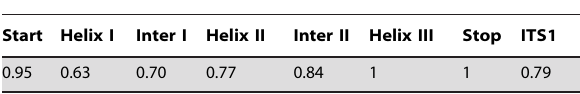
Table 2. AT content of different structural elements from neocallimastigomycete ITS1 regions in per cent.